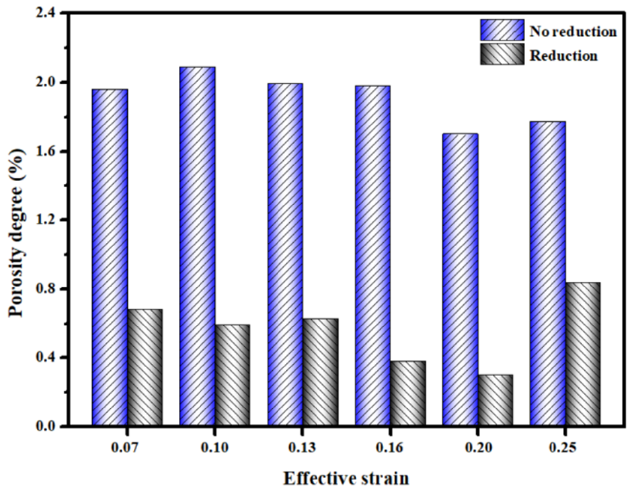
Figure 12. Results of the porosity degree for the different reduction conditions.